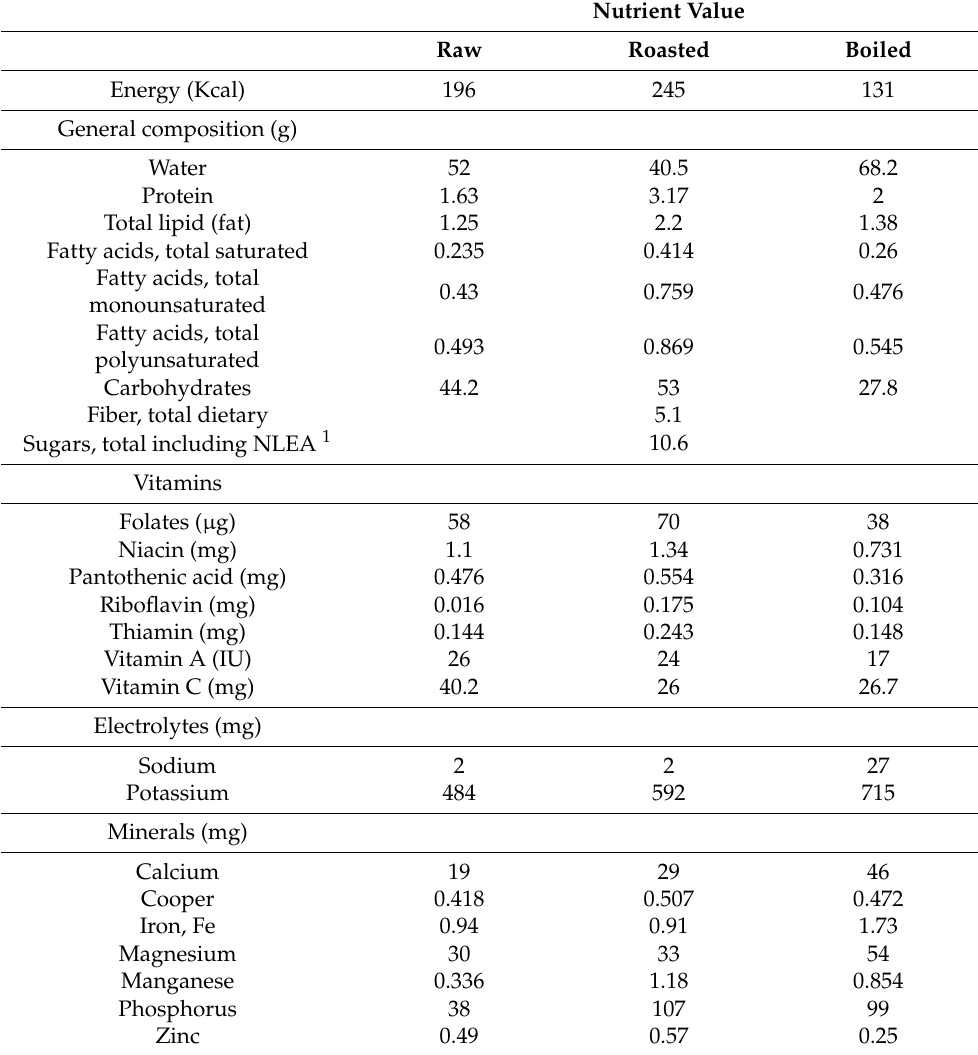
Table 1. Nutritional value of 100 g of European chestnut; Source: National Nutrient Database for Standard Reference, United States Department of Agriculture; Retrieved from FoodData Central (usda.gov) [28]. Nutrient Value Raw Roasted Boiled Energy (Kcal) 196 245